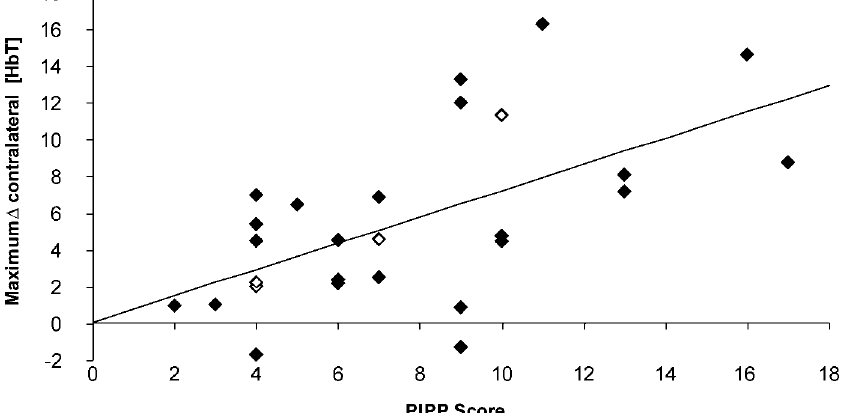
Figure 1. Relationship between the Haemodynamic Response and PIPP Score Relationship between maximum D [HbT] and the PIPP score following noxious stimulation. The open diamonds represent an infant with periventricular haemorrhage (PVH).